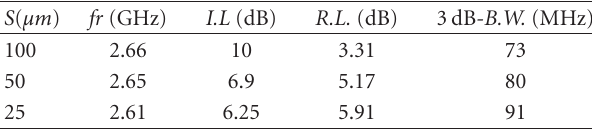
Table 2: E ff ect of changing S on the filter response.